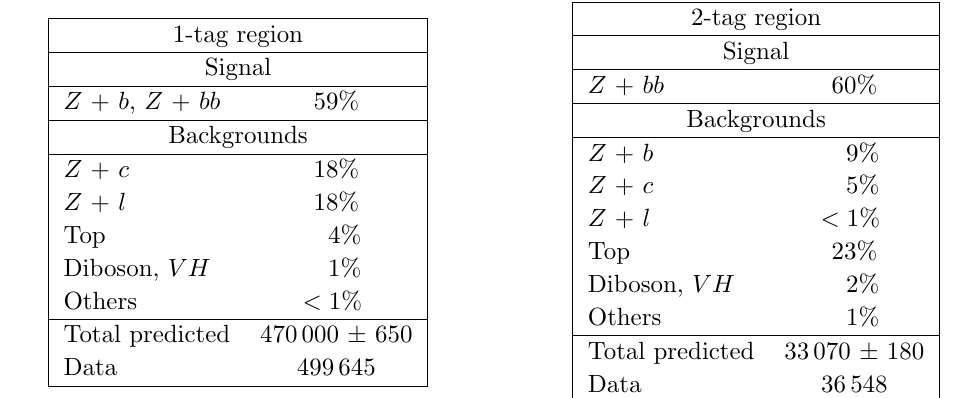
Table 6 . The expected size of the signal and backgrounds, expressed as a fraction of the total number of predicted events for inclusive b -jet multiplicities for the signal selection. The signal and Z +jets background predictions are from the Sherpa generator, with the Z +jets background estimate obtained after applying the normalisation scale factors obtained from the (cid:13)avour (cid:12)t. The total numbers of predicted and observed events are also shown. The uncertainty in the total predicted number of events is statistical